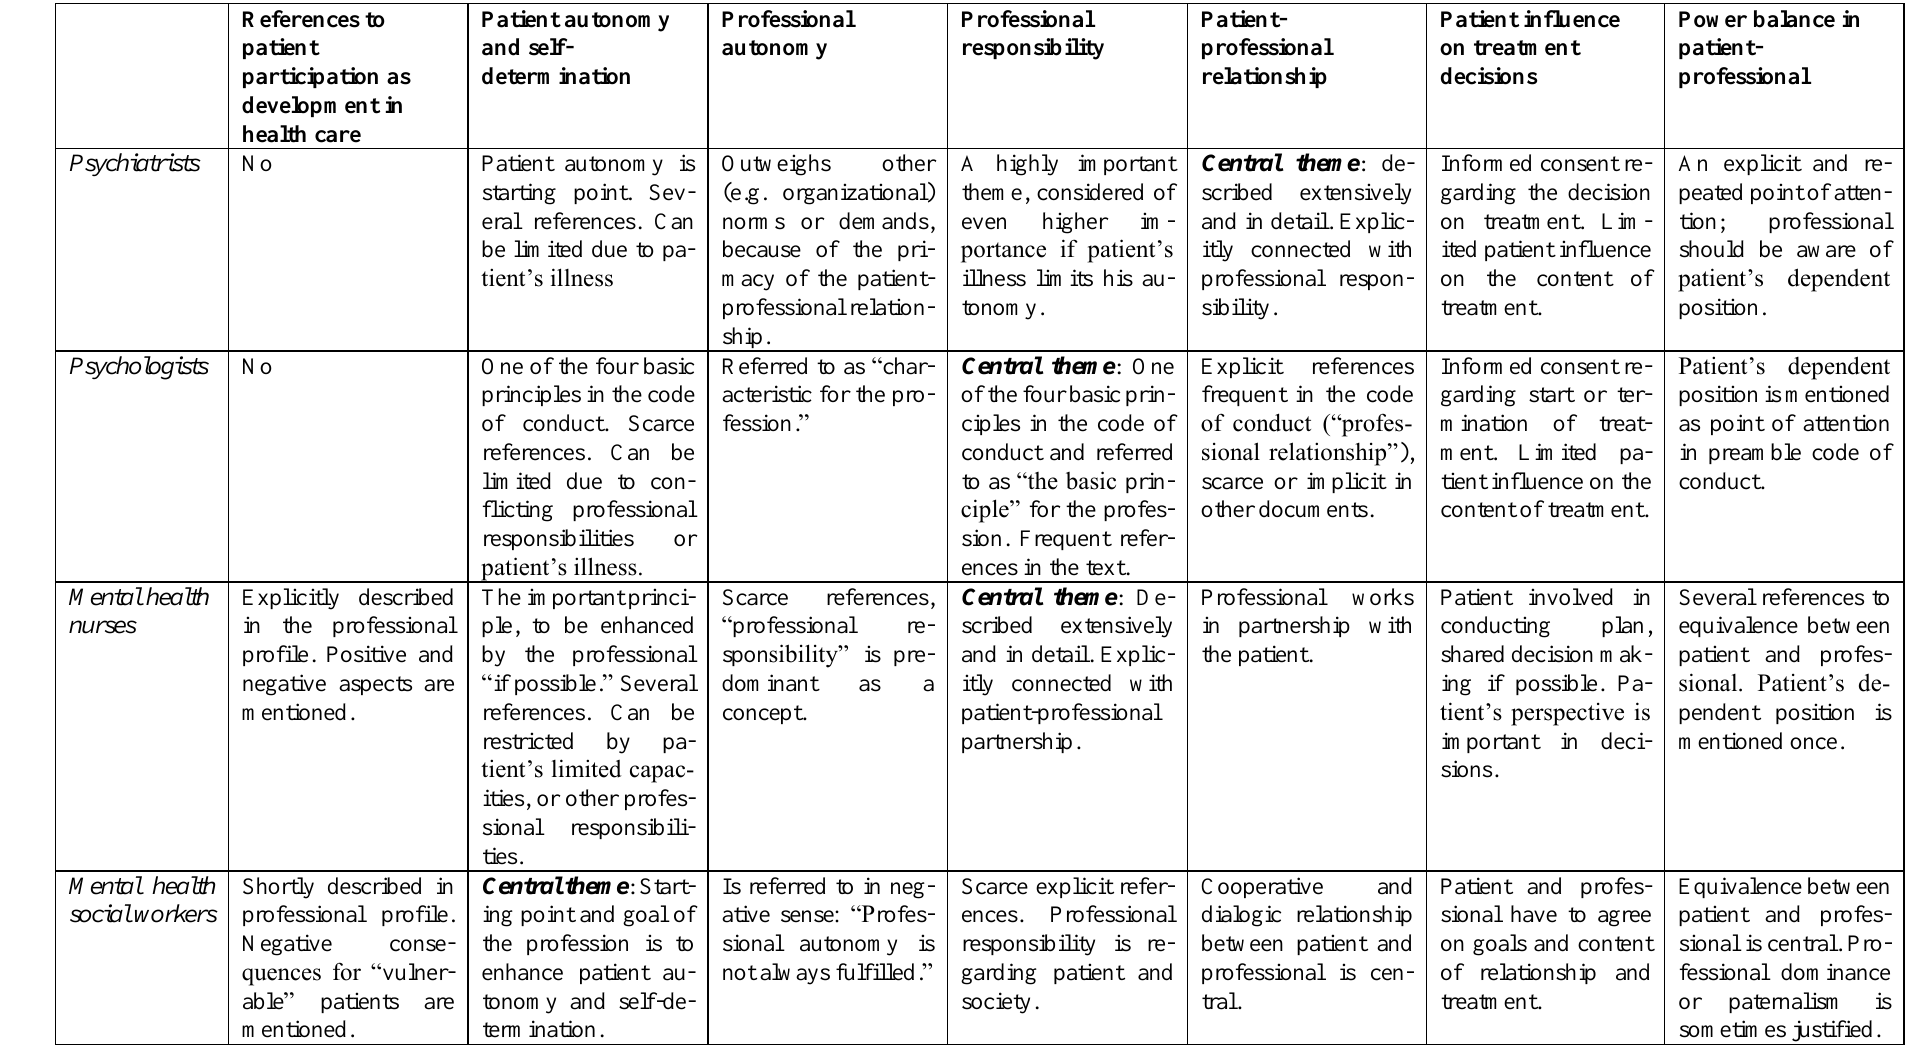
Table 2 Characteristics of four professions regarding the concepts of analysis